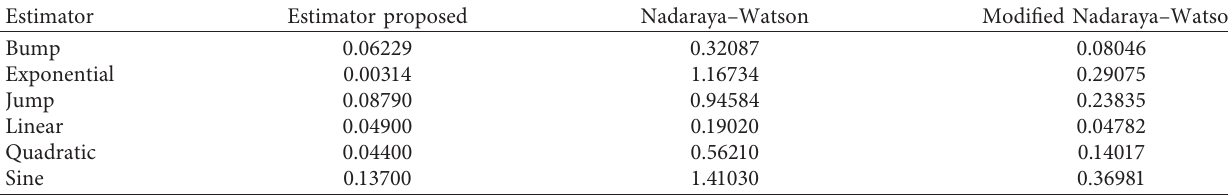
Table 3: Summary results of the mean squared error values.